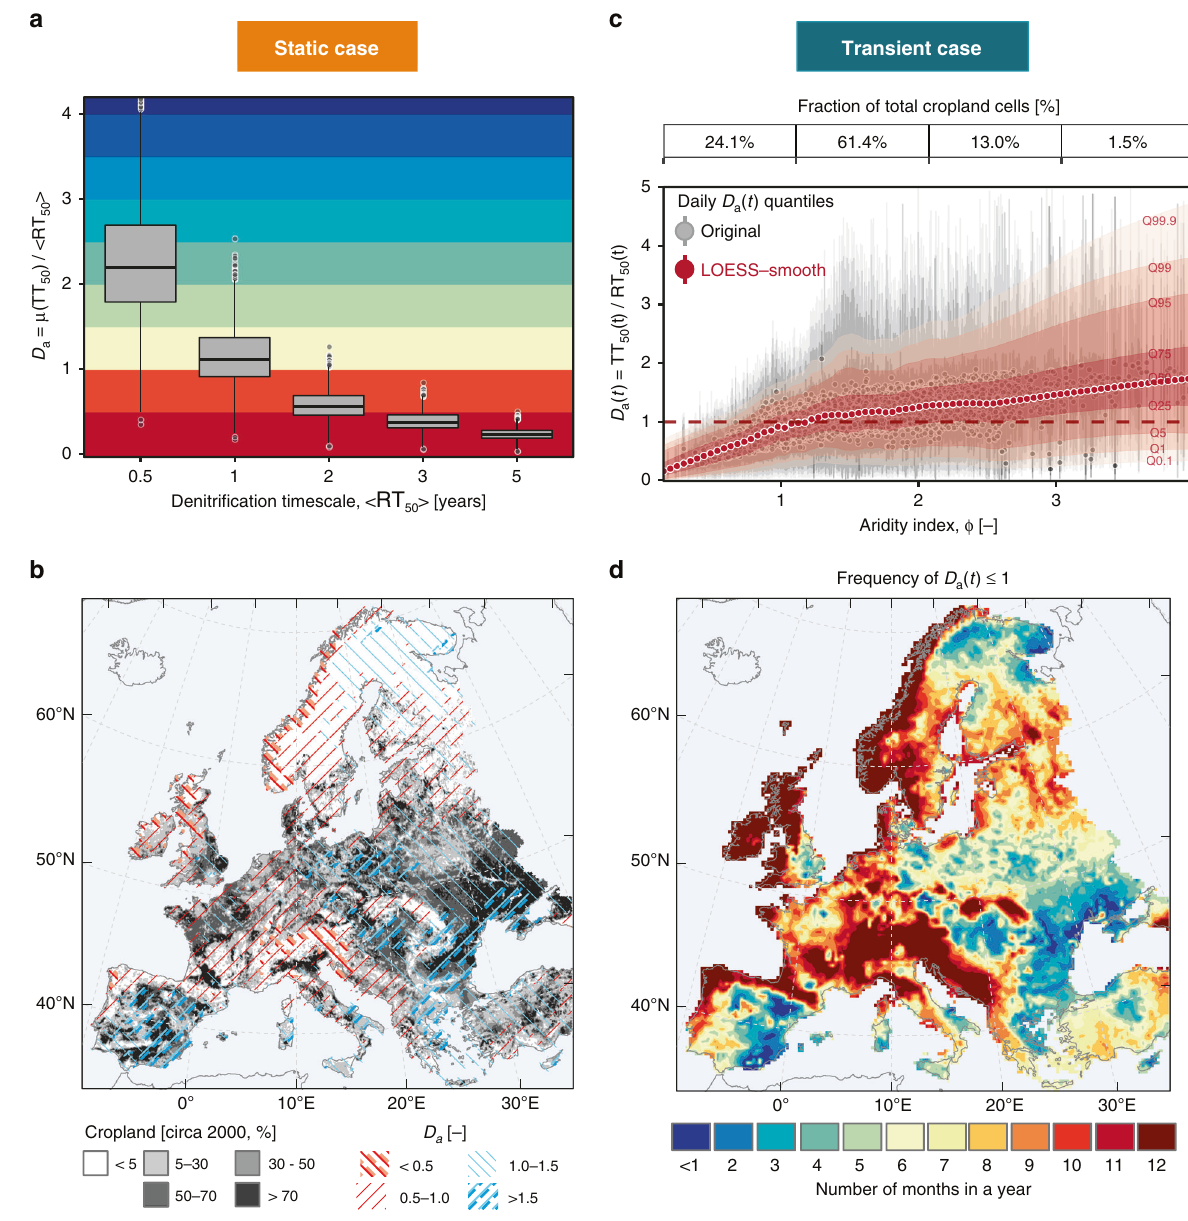
Fig. 3 Subsurface nitrate vulnerability assessment across Europe under static and transient considerations of hydrologic transport and denitri fi cation (cid:1) (cid:3) ) for a range of effective denitri fi cation timescales RT 50 timescales. a Box-plots summarizing the spatial distribution of the Damköhler number ( D a ¼ TT 50 RT 50 and the averaged transport times μ (TT 50 ) estimated across the cultivated areas of Europe 72 . Boxplot is displayed with the horizontal bar at the median, the box indicates the fi rst and third quartiles and the whiskers indicate ±1.5 times the interquartile range. Grid cells with at least 5% of the cropland areas are considered cultivated areas in the analysis. b Europe-wide D a estimates for the static vulnerability assessment case corresponding to the effective reaction (cid:1) (cid:3) timescale, RT 50 and the average transport timescales, μ (TT 50 ). Areas with D a ≤ 1 are vulnerable to subsurface nitrate leaching and ~42% of the total cultivated area falls within this category under the static vulnerability assessment case. c Summary of the transient daily D a (t) estimates for every cultivated grid cell, arranged according to their corresponding aridity index values ( ϕ ). Summary statistics are presented as quantiles of the daily D a values (Q0.1,1,5, ...,95,99,99.9) for the actual estimates (in background) and the LOESS (locally weighted smoothing)-derived smooth statistics (in a transparent foreground for better clarity). d Frequency of the daily D a ( t ) ≤ 1 estimated based on the time-varying TT 50 (t) and RT 50 (t). Considering the transient nature of D a , nearly 75% of cultivated areas of Europe become vulnerable to nitrate leaching ( D a ( t ) ≤ 1) for at least one-third of the year (i.e., frequency estimates ≥ 0.33 or